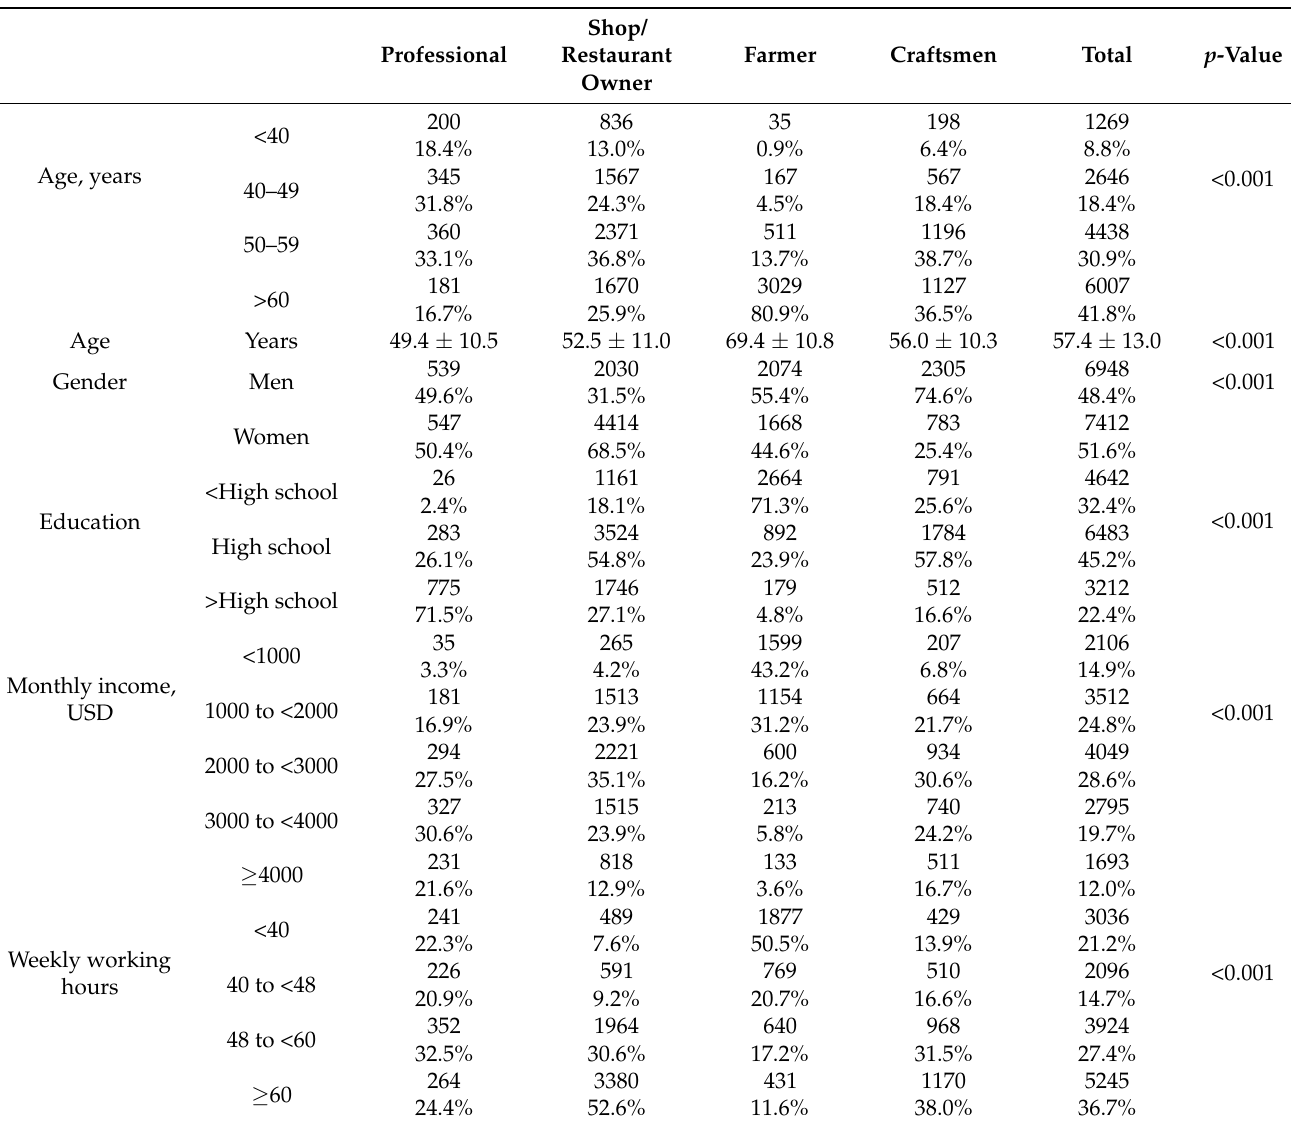
Table 2. Demographic, socioeconomic, and psychosocial work-related factors of self-employed workers in different occupational